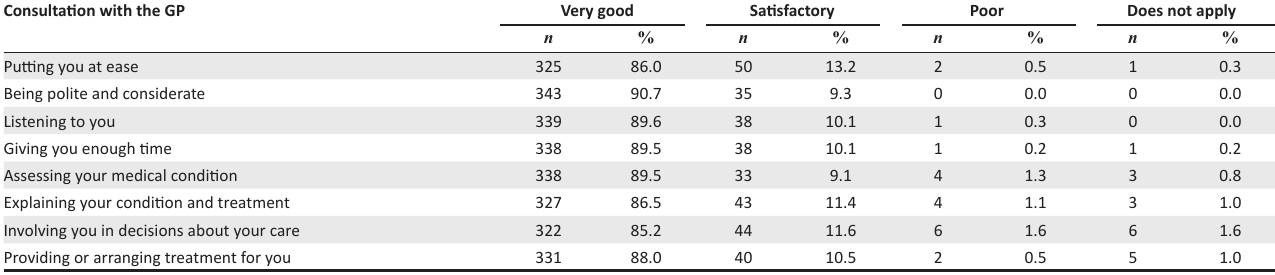
TABLE 3a: Patients’ perspective on the consultation, relationship with the general practitioner and care enablement ( N = 378). Consultation with the